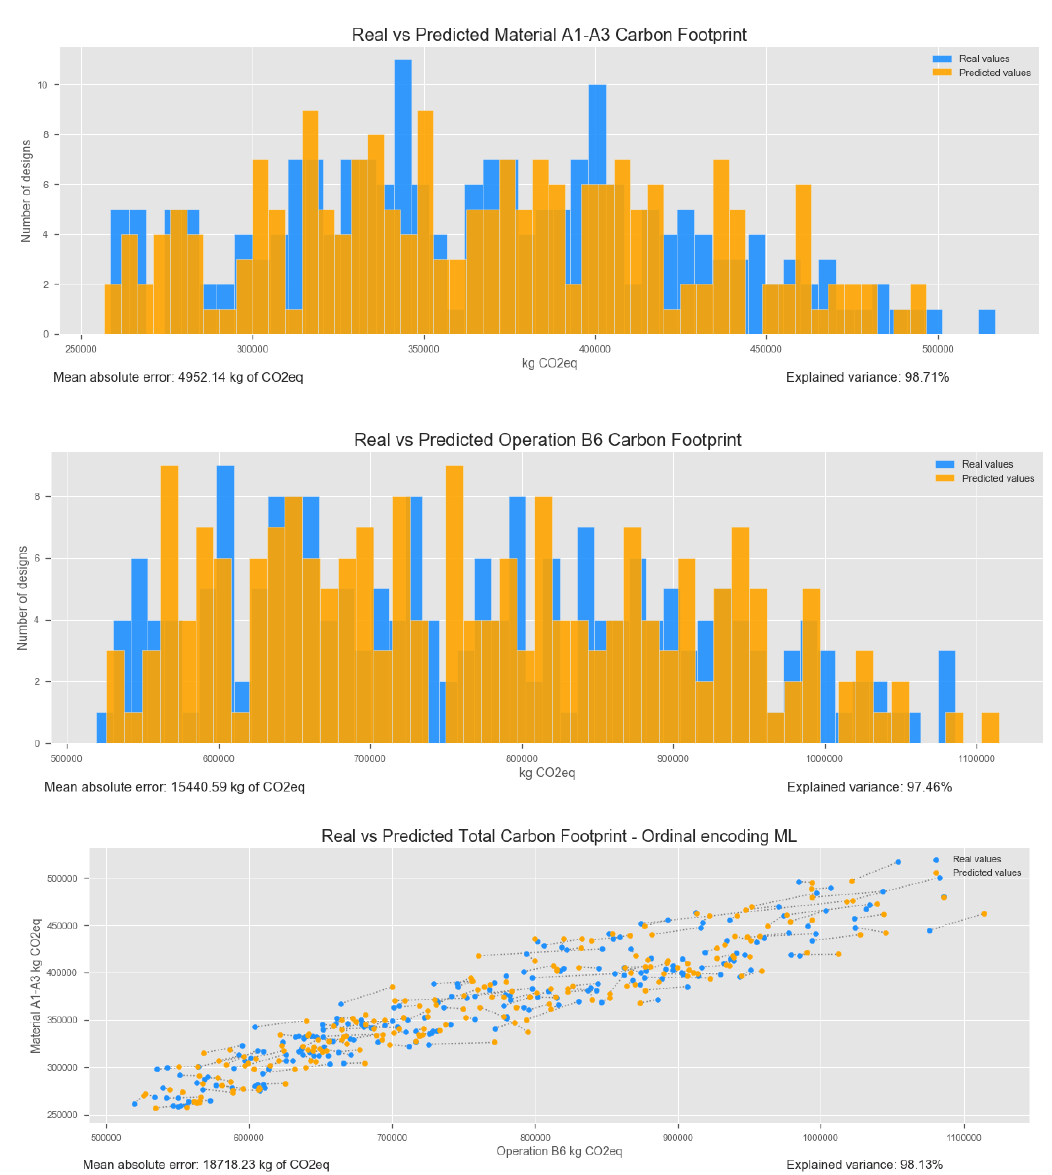
Figure 8. Results of the training process showing the better fit of the Embodied Carbon ML model, and slightly worse fit of Operational Carbon ML model.